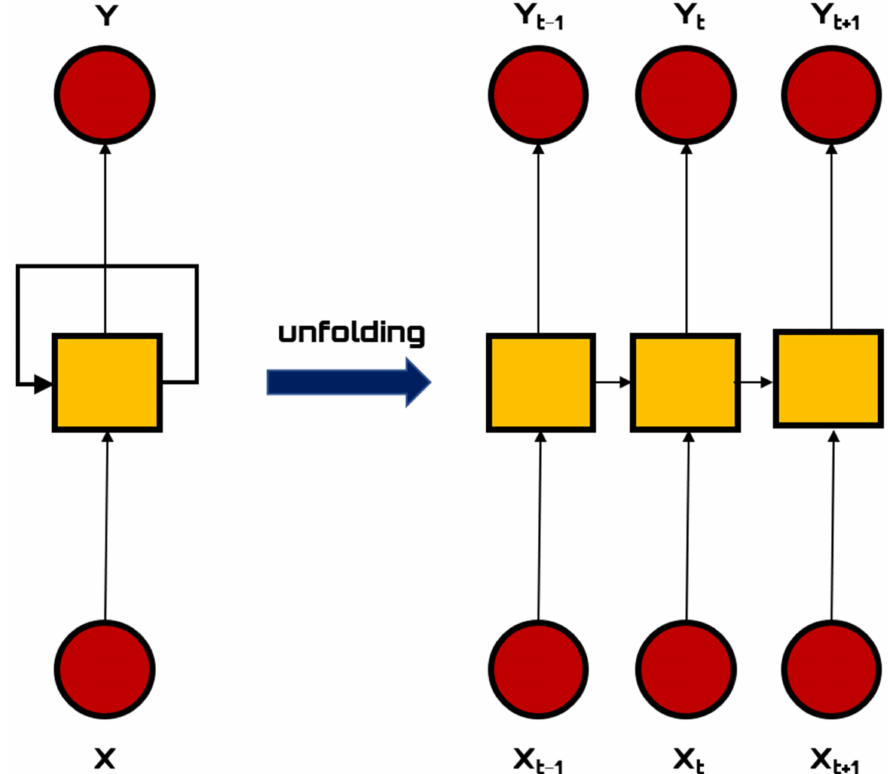
Figure 6. RNN architecture unfolded: feedforward version of network of arbitrary length depending on a sequence of inputs. Number of blocks of unfolded version essentially depends on length of sequence to be analyzed. Within the network, it represents a pattern that temporally links elements of the series that RNN